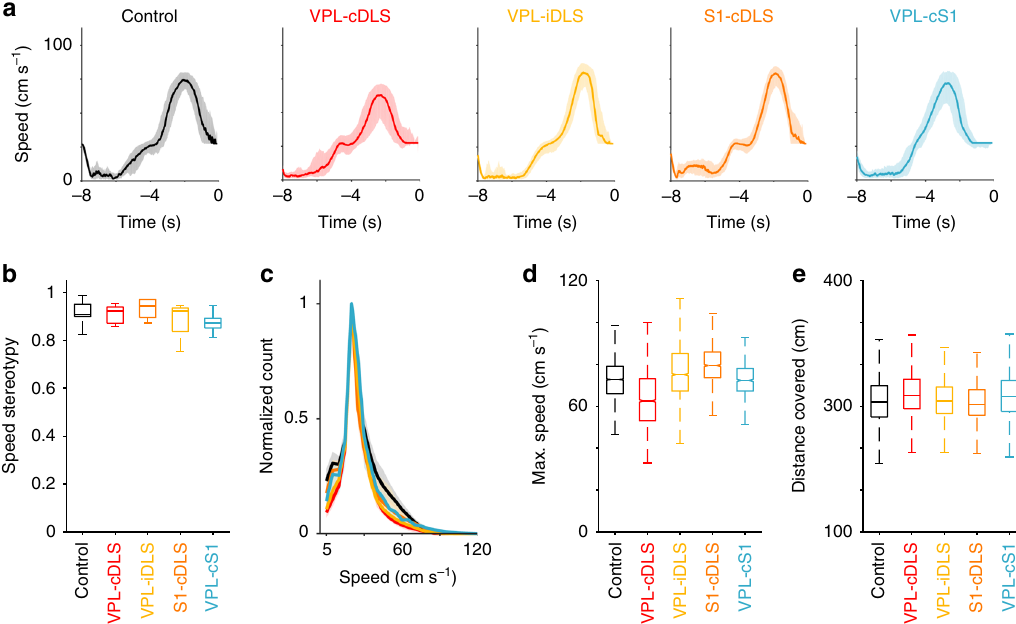
Fig. 5 Effects of disrupting sensory fl ow information on speed control. a Speed trajectories (median + 75th and 25th percentiles) for one representative animal from each experimental group (color code as in Fig. 4). b Speed stereotypy index for all experimental groups (median + 75th and 25th percentiles). c Normalized distribution of running speeds (median + 75th and 25th percentiles) expressed during the punishment periods of incorrect trials for the different experimental groups. Maximum speeds ( d ) and distance traveled ( e ) for the same conditions as in ( c ) (median + 75th and 25th percentiles)